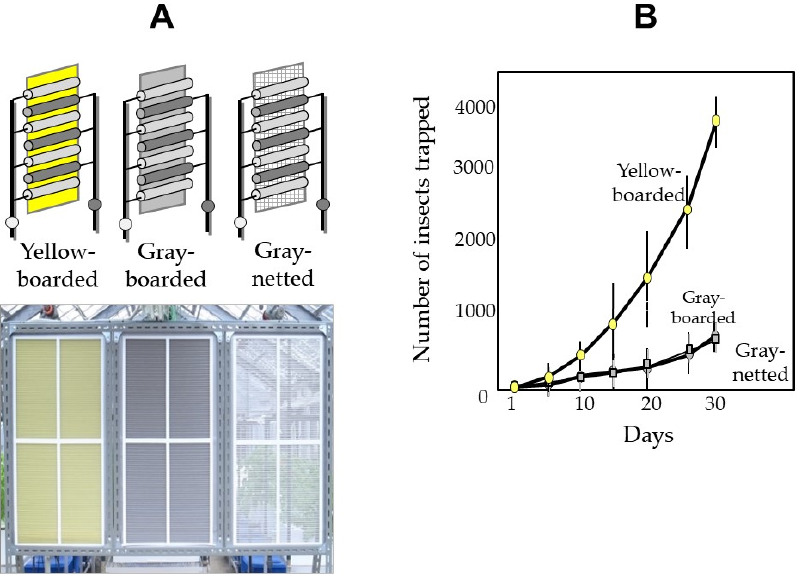
Figure 17. ( A ) Three types of 1L DD screen examined in a greenhouse assay. Three 1L DD screens backed with a yellow board, gray board, or gray net (left to right) were fixed with a metal frame and placed in a greenhouse, where 50 tomato plants were heavily infested with numerous whiteflies, for 1 month. ( B ) Whitefly capture by the three DD screens [9].